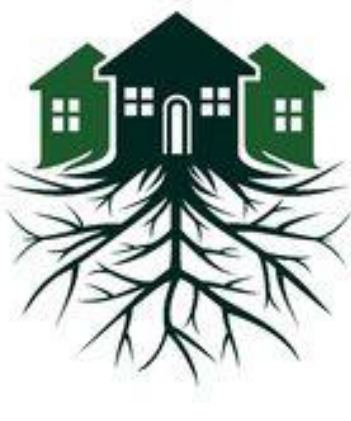
Figure 1 The house of affection: The